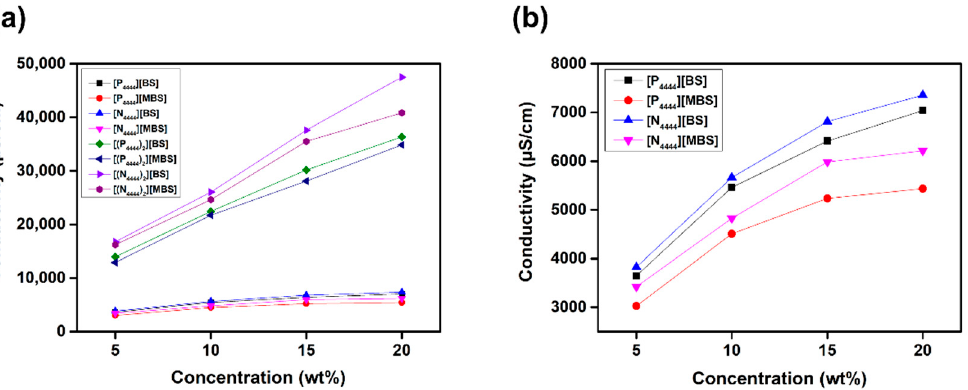
Figure 5. Conductivity of ( a ) [P 4444 ][BS], [N 4444 ][BS], [P 4444 ][MBS], [N 4444 ][MBS], [(P 4444 ) 2 ][BS], [(N 4444 ) 2 ][BS], [(P 4444 ) 2 ][MBS], and [(N 4444 ) 2 ][MBS] ( b ) [P 4444 ][BS], [N 4444 ][BS], [P 4444 ][MBS], and [N 4444 ][MBS] aqueous solutions according to concentration.